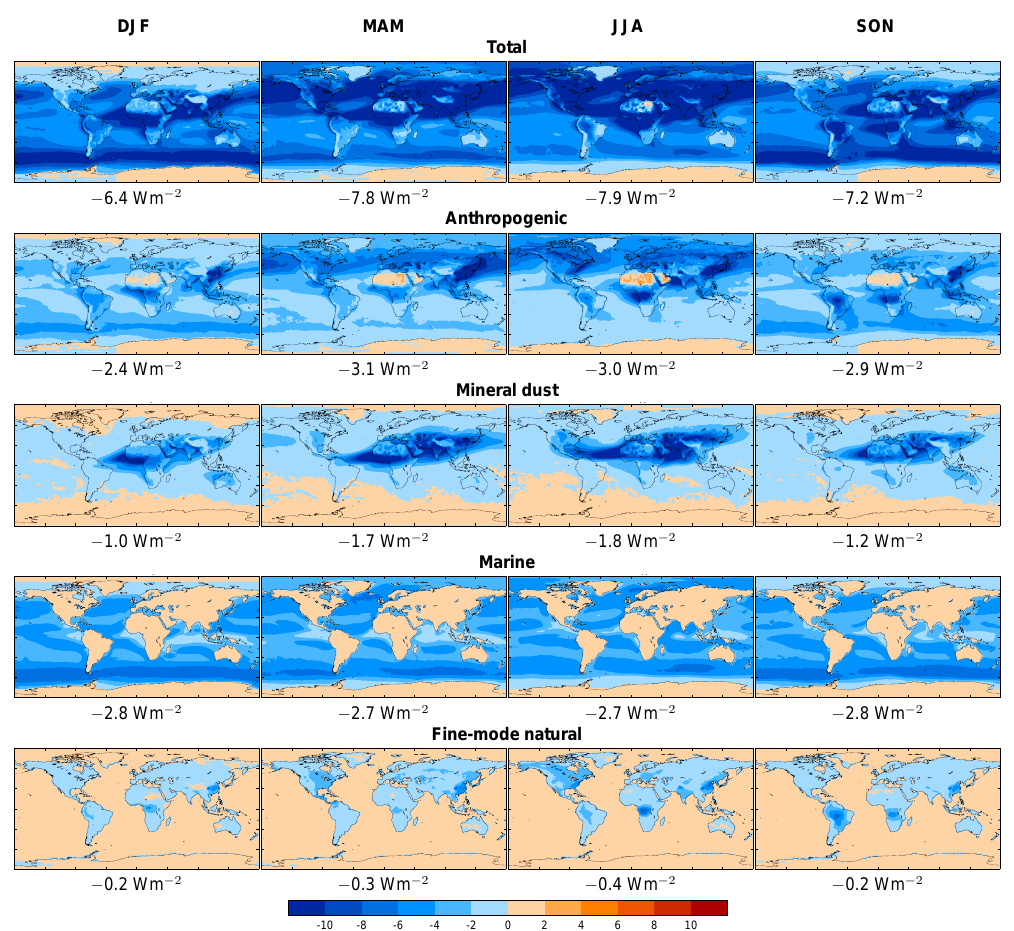
Fig. 4. Seasonal distributions of shortwave direct radiative effect in cloud-free sky at the top of the atmosphere, in Wm − 2 , as derived from the MACC re-analysis over 2003–2010. From top to bottom, the direct effect is for total, anthropogenic, mineral dust, marine, and fine-mode natural aerosols. Global averages are given by the numbers below each